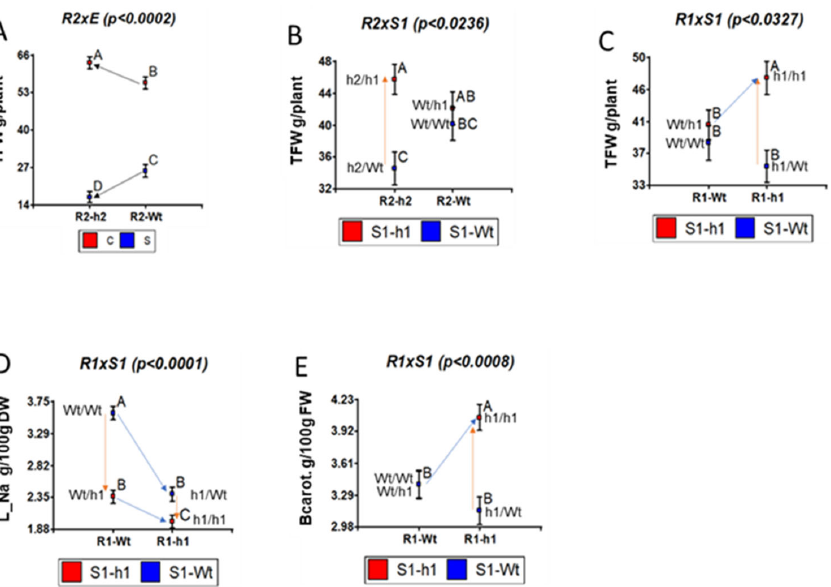
Figure 3. Graphic representation of relevant interactions involving rootstock genotype at HKT1.1 (R1) and HKT1.2 (R2) and salinity treatment (E) for total fruit yield (TFW): ( A ) R2 × E, ( B ) R2 × S1, and ( C ) R1 × S1. ( D ) R1 × S1 interaction for leaf Na content (L_Na in g/100g of dry weight), and ( E ) fruit β‐ carotenoids (BCarot., mg/100g fresh weight). Means with different letters are significantly different at 5% level. Arrows show the directions of the effects of silencing SgHKT1;1 at the scion (orange arrows) and at the root (blue arrows), and silencing SgHKT1;2 at the root (black arrows).